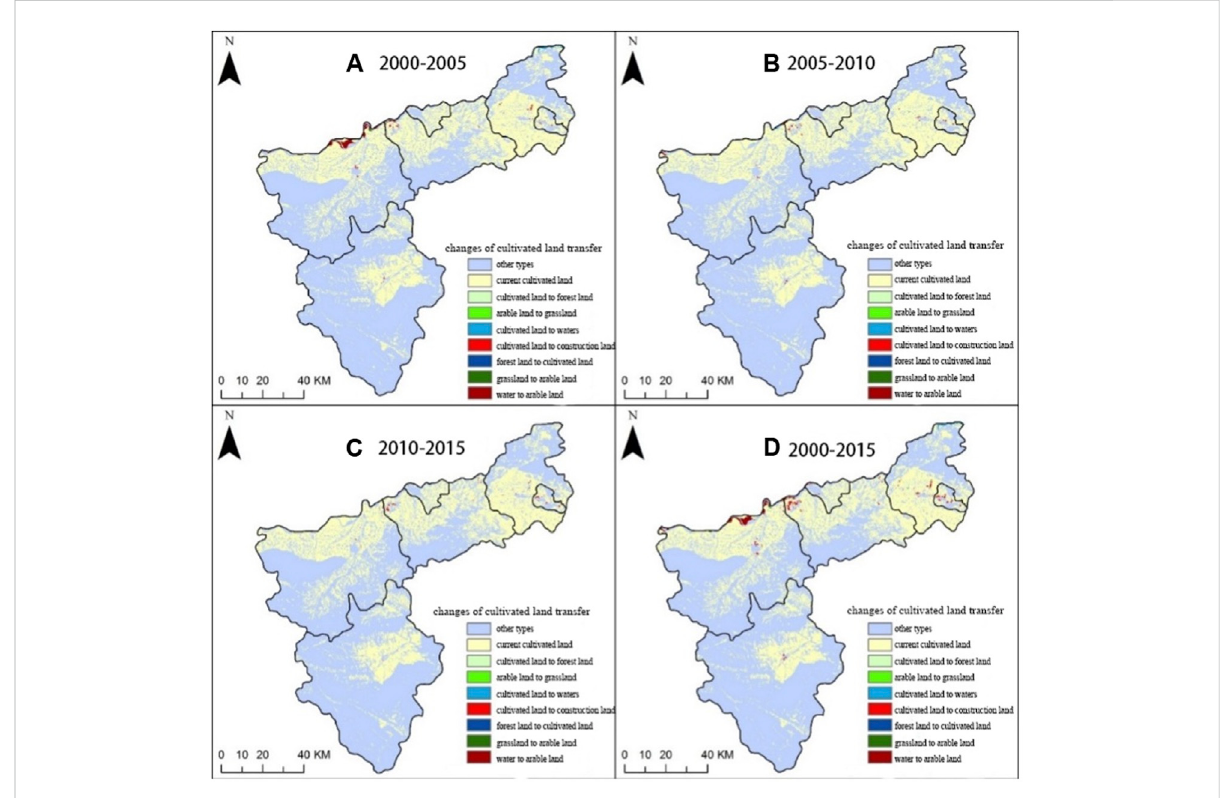
FIGURE 4 Direction of farmland transfer in Sanmenxia